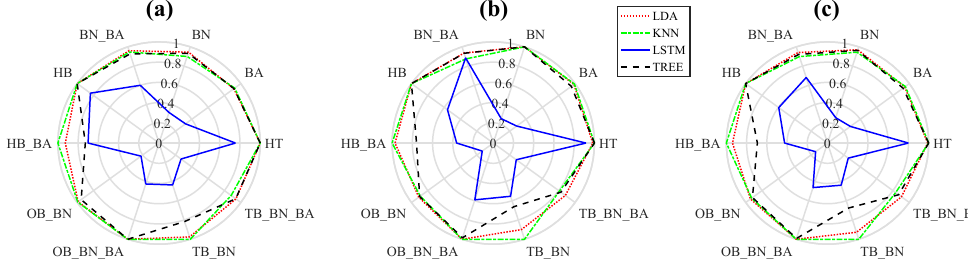
Figure 6. Resulting graph of four single classes and six combinations: ( a ) precision, ( b ) recall, and ( c )